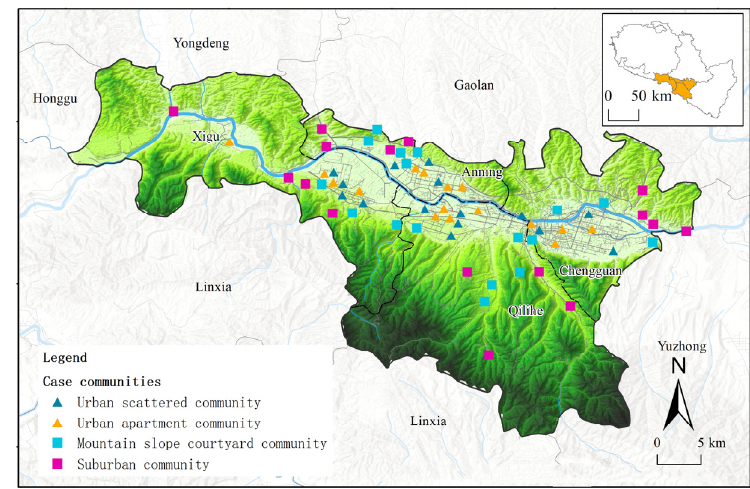
Figure 1. Case community distribution map of Lanzhou.